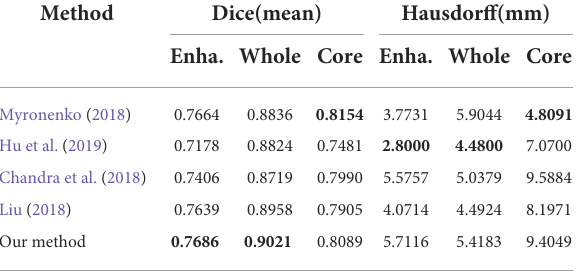
TABLE 7 Comparison to other methods on BRATS2018 validation dataset.